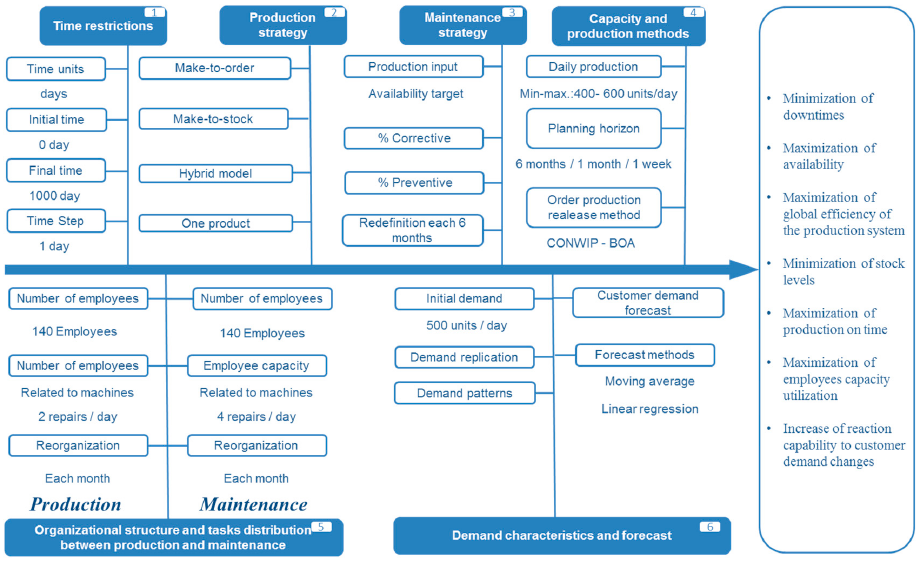
Figure 10. Ishikawa Diagram of Hypothesis for the simulation model (own elaboration).